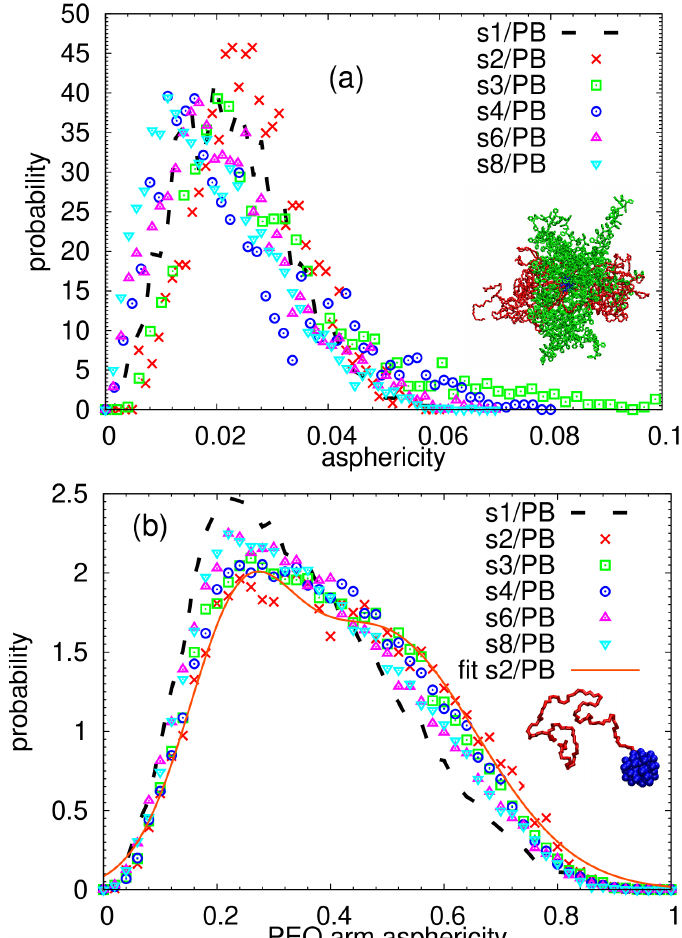
Figure 2. The shape parameters of the individual stars in the assembly: the distributions of ( a ) the star asphericity and ( b ) the PEO arm asphericity together with a randomly selected snapshots of ( a ) a star and ( b ) a PEO arm connected to the core chosen from the s3/PB system. The solid line in ( b ) represents the best fit of the s2/PB data to a sum of two Gaussian